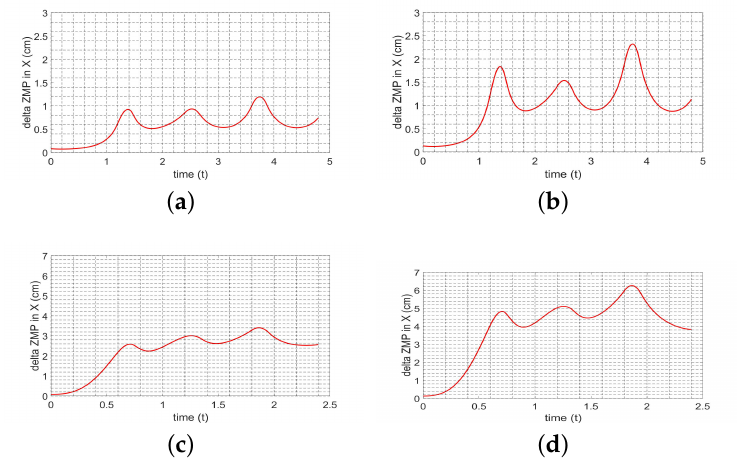
Figure 14. the value of the ∆ x zmp : ( a ) r c = 1.06 m, v ave = 1 km/h, ( b ) r c = 0.67 m, v ave = 1